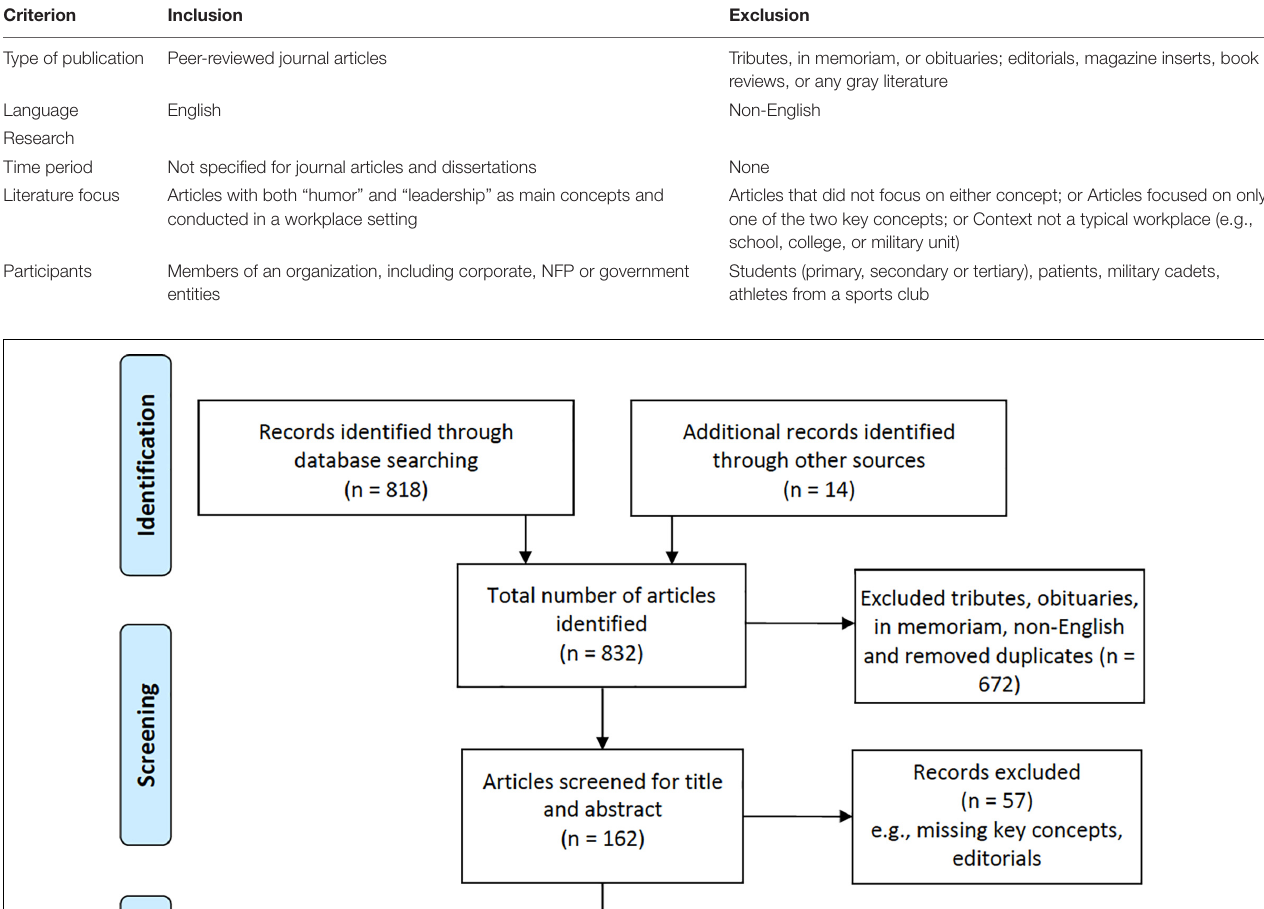
TABLE 3 | Inclusion and exclusion criteria for article selection.